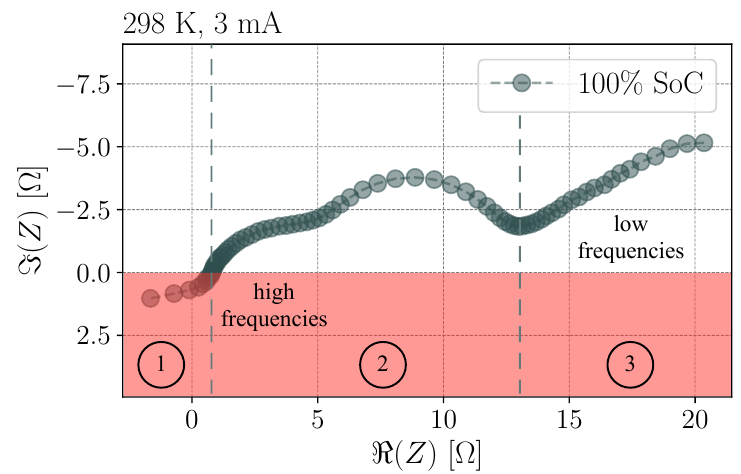
Figure 2. EIS measurement of a ZAB at 298 K and SoC of 100%. The red marked area shows the transition to the inductive parts which is not considered by default (1), (2) is the area that can be described well via the DRT, and (3) represents a sensitive area.